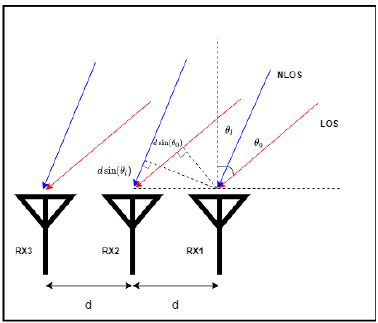
Figure 4. Example of additional RSSI attenuation on antenna